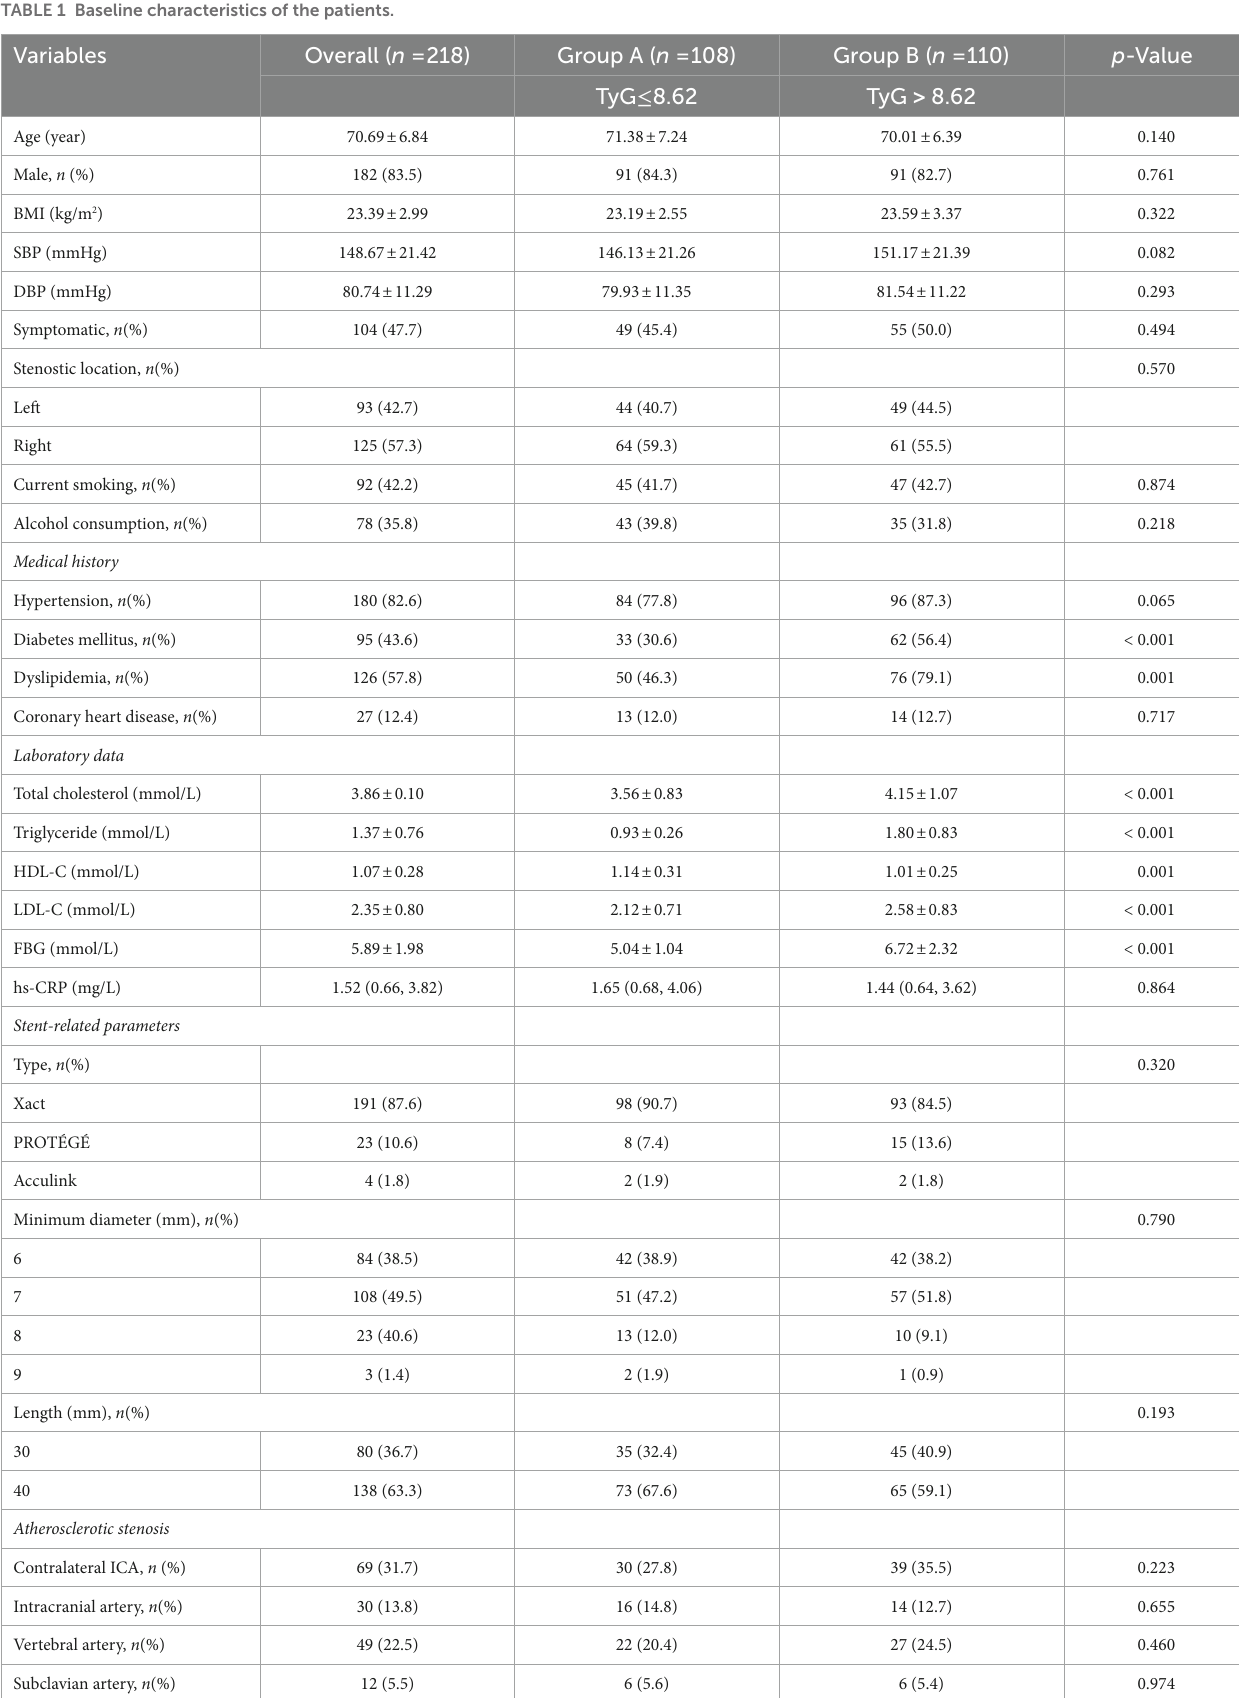
TABLE 1 Baseline characteristics of the